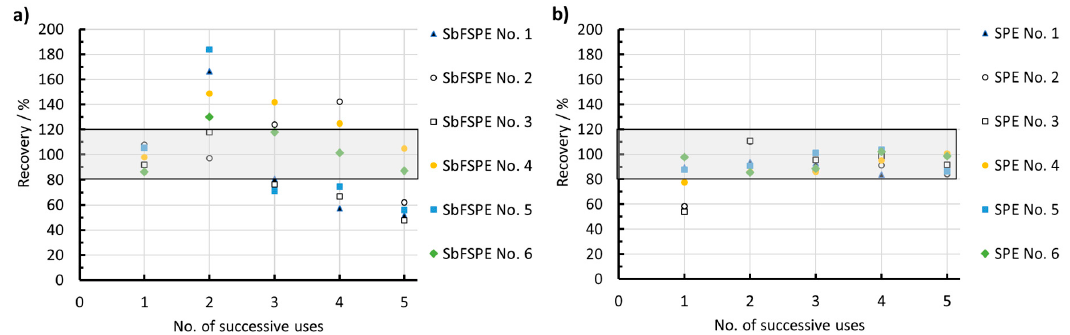
Figure 5. Recovery vs. the number of successive multiple standard addition analyses using the same sensor (repeated for six ( a ) SbFSPE and six ( b ) bare SPE sensors). The same experimental conditions were employed as in Figure 2.